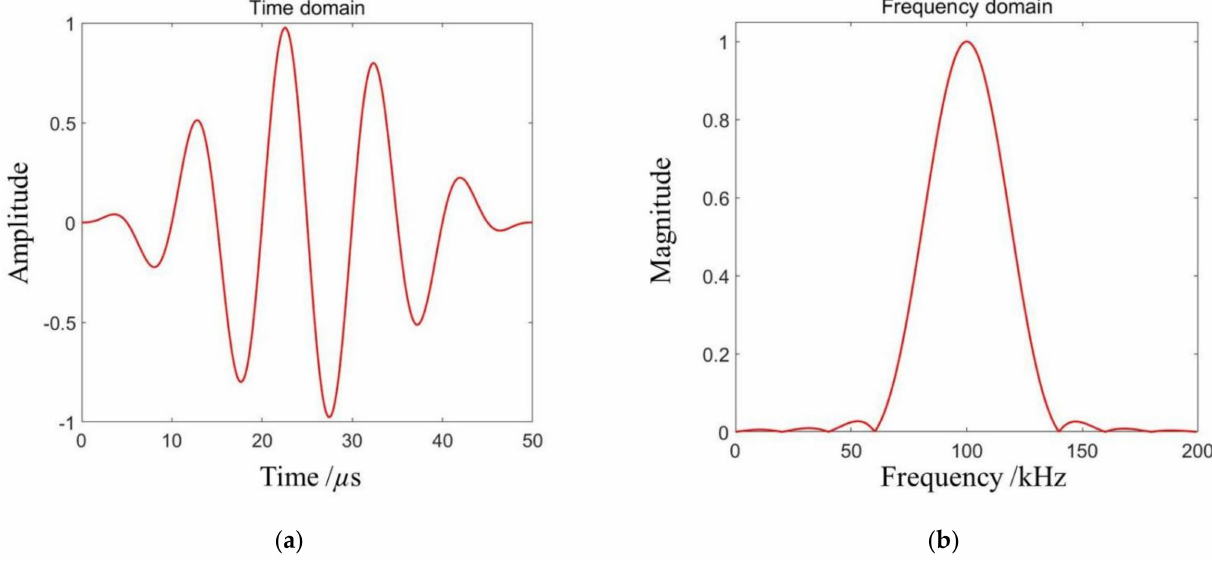
Figure 3. ( a ) Time-domain diagram of the excitation signal. ( b ) Frequency-domain diagram of the excitation